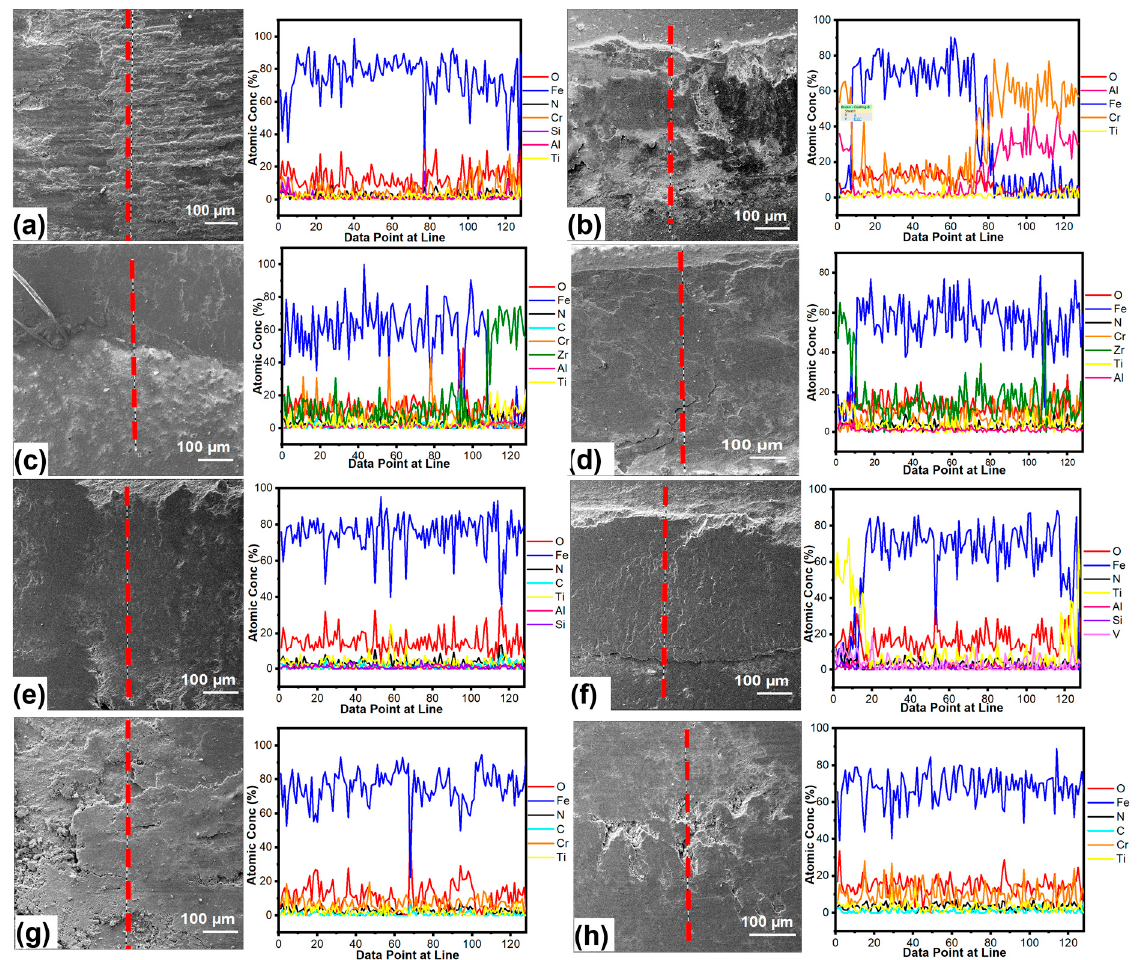
Figure 12. SEM/EDX lines scans of the worn surfaces at 700 °C wear and friction test; ( a , b ) coating A on non-nitrided steel and nitrided steel, ( c , d ) coating B on non-nitrided steel and nitrided steel, ( e , f ) coating C on non-nitrided steel and nitrided steel, ( g , h ) coating D on non-nitrided steel and nitrided steel, respectively.